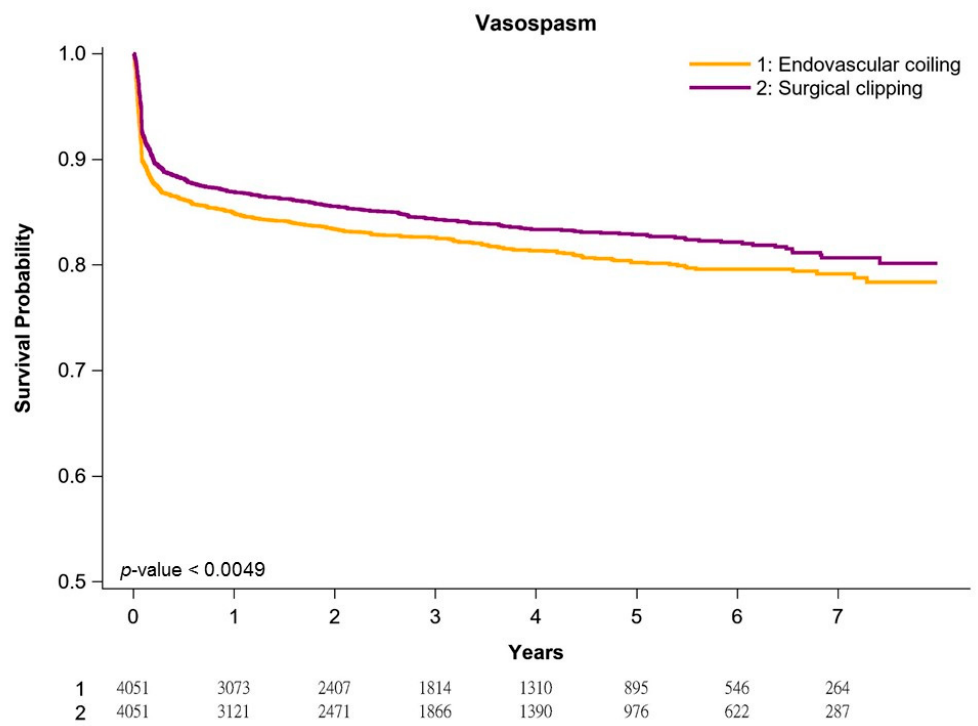
Figure 2. Kaplan–Meier vasospasm-free survival curves of propensity score-matched patients.